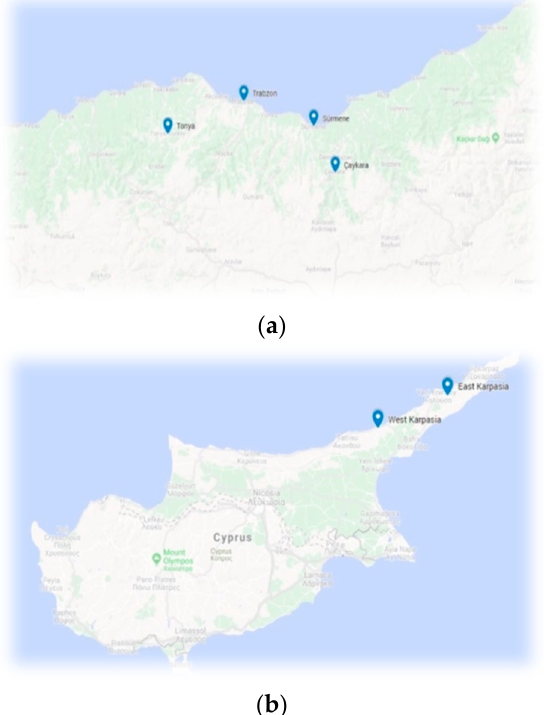
Figure 1. ( a ) Pontic Greek-speaking villages in Trabzon. ( b ) Transplanted Pontic Greek speakers in Karpasia.